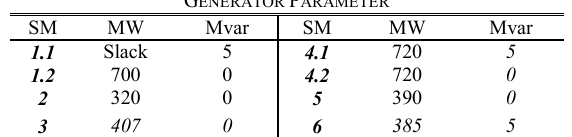
TABLE II S YNCHRONOUS M ACHINE T YPE D ATA